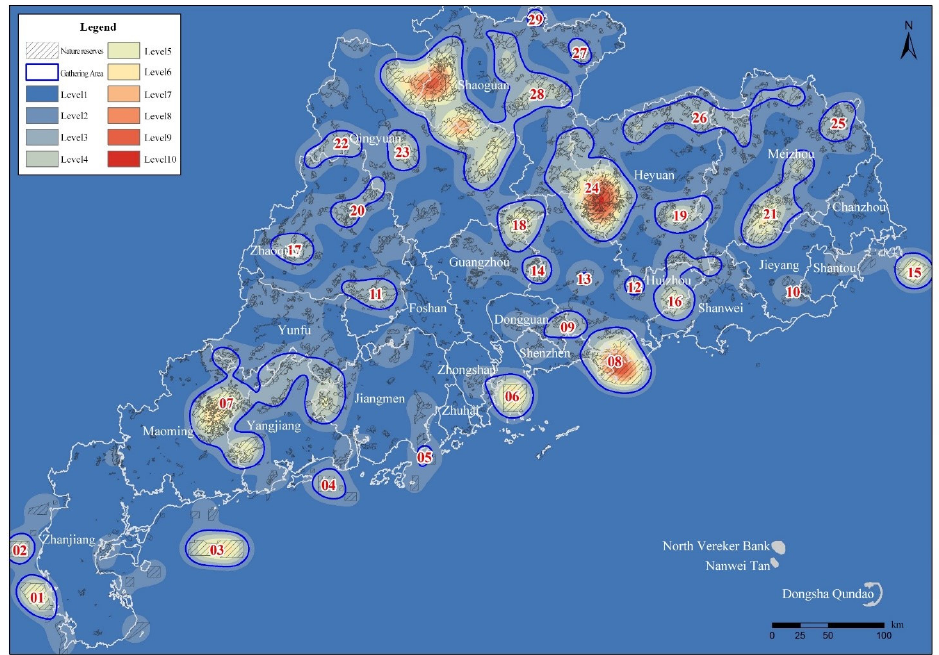
Figure 13. Agglomeration area distribution of NPAs in Guangdong Province. (The numbers in the figure are the sequential numbers of NPAs Agglomeration areas).